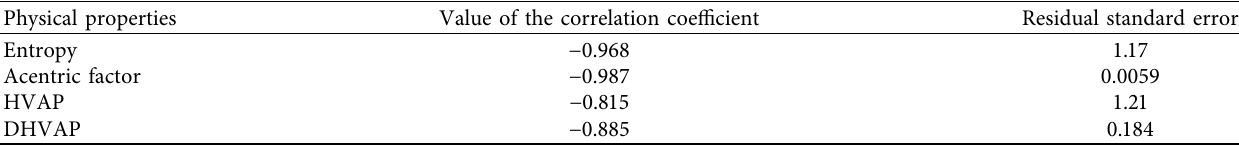
Table 2: Parameters of regression models for the GH index.